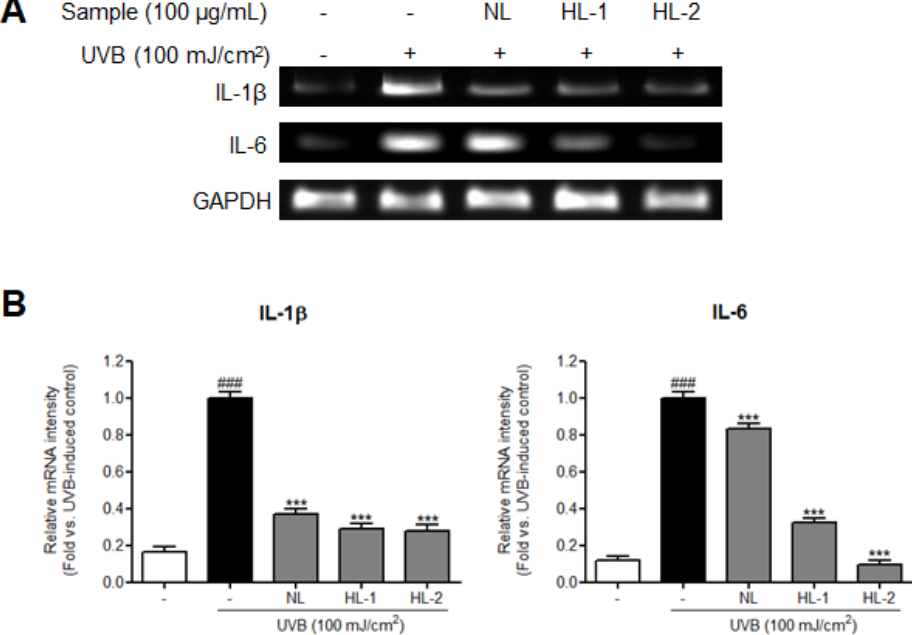
Figure 4. Effect of heat-treated-licorice extracts on proinflammatory mRNA cytokines in UVB-exposed HDFs. RT-PCR was performed to confirm the mRNA levels of IL-1 β and IL-6. The mRNA band intensities were normalized to that of GAPDH and presented as the mean ± SD ( n = 3). *** p < 0.001 vs. UVB-exposed control; ### p < 0.001 vs. non-treated control. GAPDH, glyceraldehyde 3-phosphate dehydrogenase; HDFs, human dermal fibroblasts; HL-1, heat-treated licorice (120 ◦ C); HL-2, heat-treated licorice (130 ◦ C); IL, interleukin; NL, non-treated licorice; UVB, ultraviolet